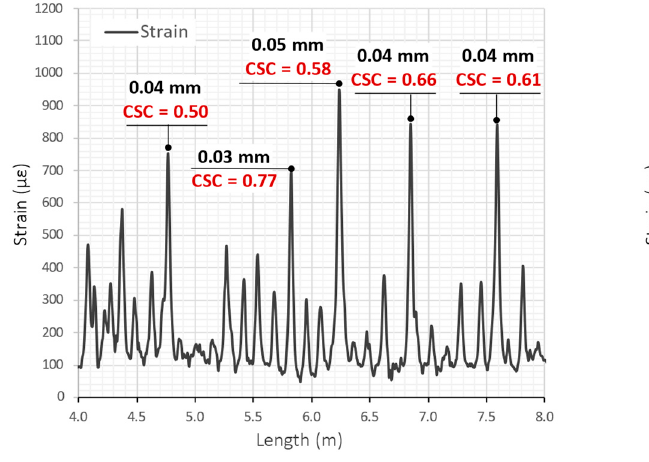
Figure 31. Example analysis of crack widths and crack shape coefficients based on measured strain profiles in the bridges in question: ( a ) near the city of Sande; ( b ) near the Frankfurt am Main.